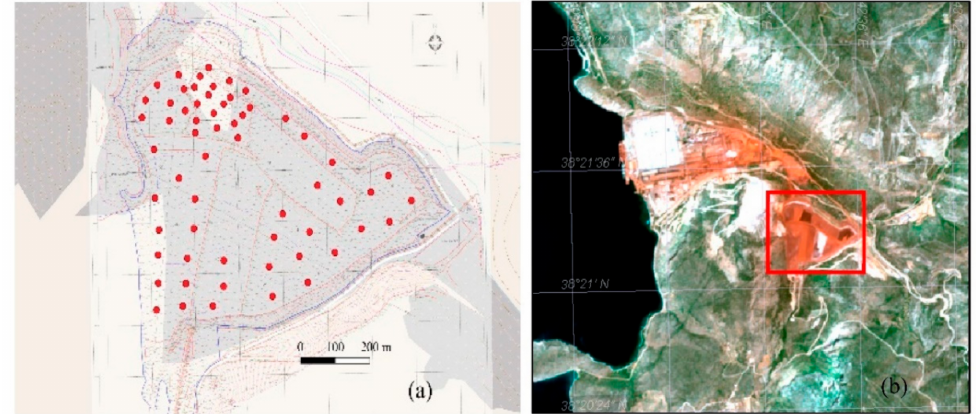
Figure 2. Samples location at the end of July 2019 ( a ) and Sentinel-2 true color composite image ( RGB = 4,3,2); date: 30 July, 2019; the red line indicates the BR area ( b ).